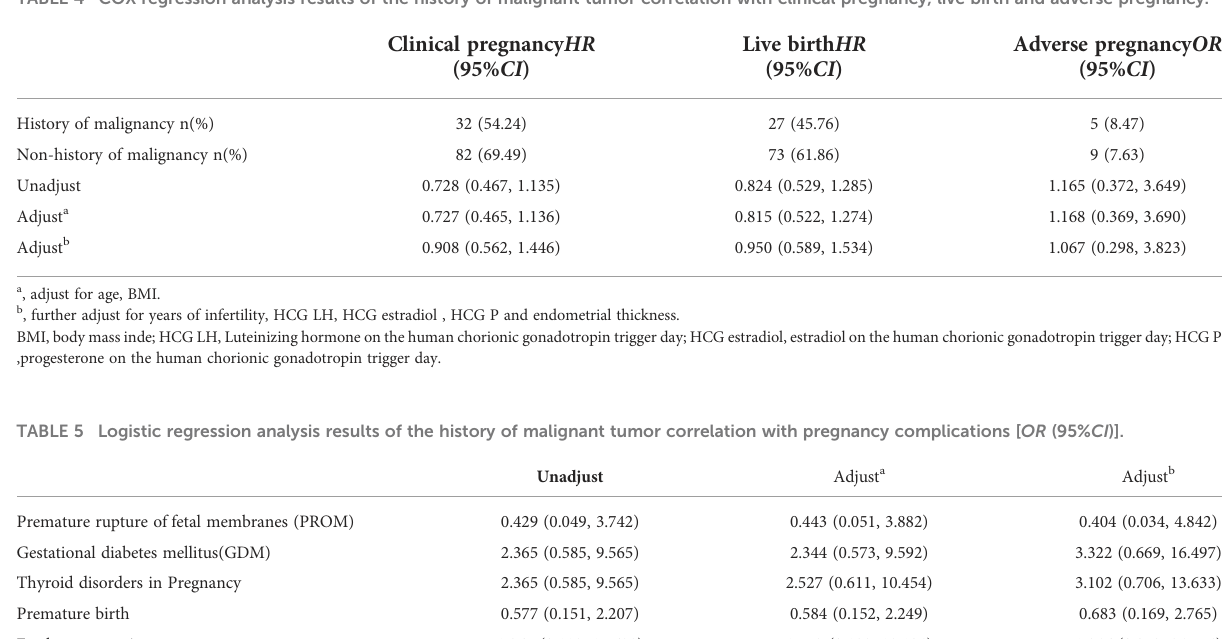
TABLE 4 COX regression analysis results of the history of malignant tumor correlation with clinical pregnancy, live birth and adverse